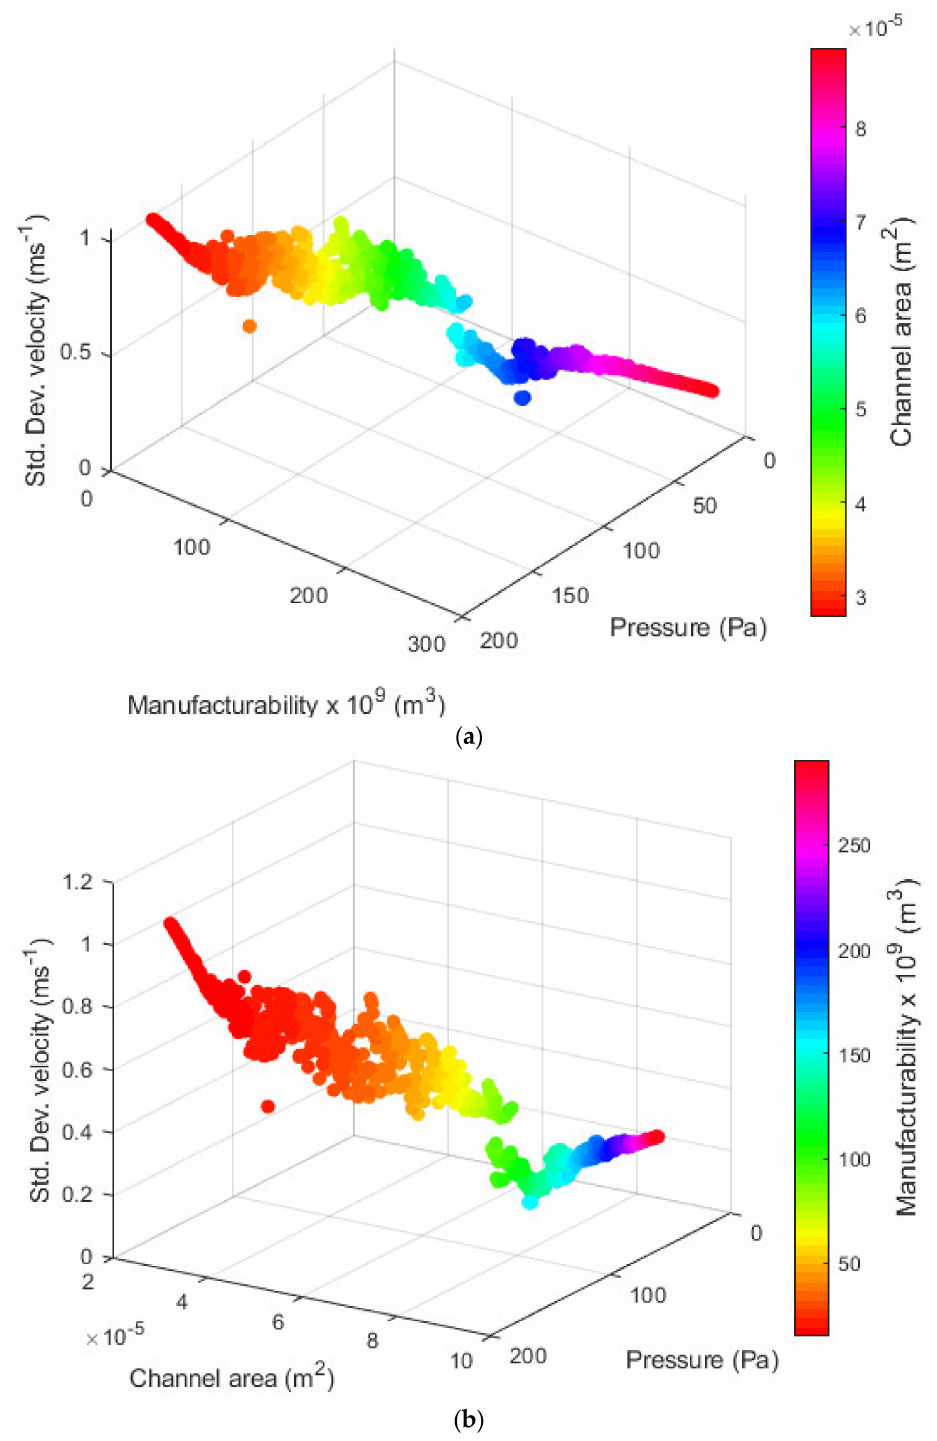
Figure 8. Four-objective plot of 3 × 3 flow field: ( a ) P vs. M vs. S and A chan in color; ( b ) P vs. S vs. A chan with M in